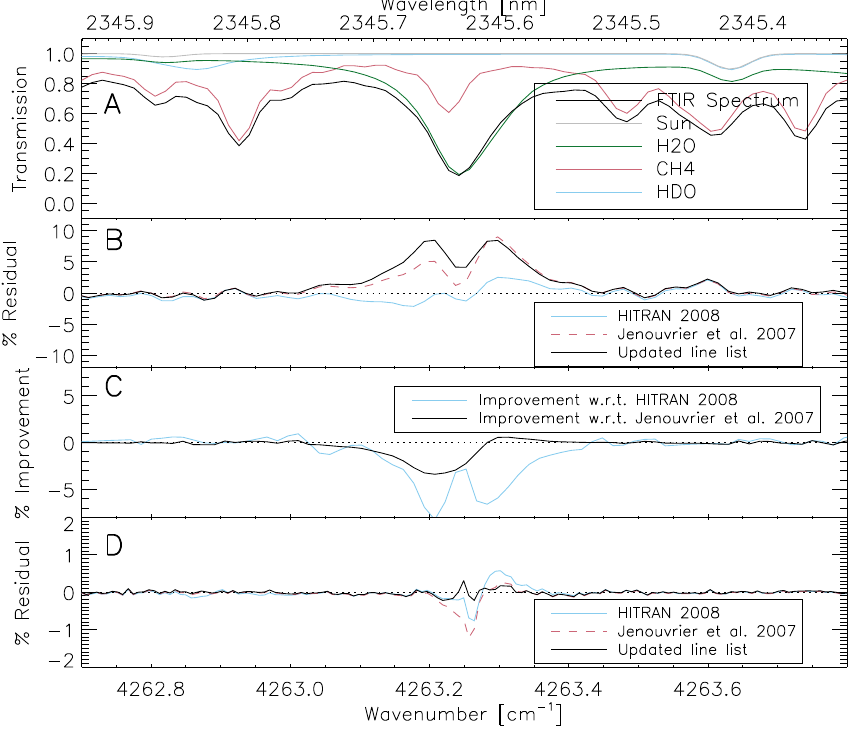
Fig. 5. Close-up of Fig. 4 around a line of which the residuals deteriorate. (A) Measured normalized transmission. The different colours show the contributions of all the modelled species. (B) Residuals. (C) Difference between the absolute values of the residuals. (D) The corresponding laboratory fit